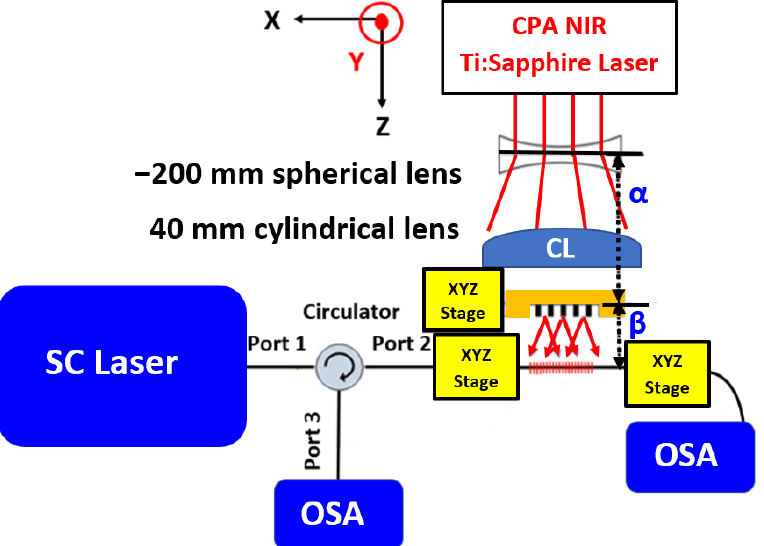
Figure 2. Experimental setup: A negative defocusing spherical lens with a focal length of f = −200 mm is positioned at a distance α in front of the PM. The PM is mounted onto an XYZ stage, which is located at a distance β in front of the fiber. A positive f = 40 mm cylindrical lens (CL) focuses the femtosecond inscription beam onto the fiber core. The fiber is connected to a broadband super con- tinuum laser source (SC laser) via Port 1, and to an OSA at the other two ports via a circulator (Port 2 for transmission and Port 3 for reflection).